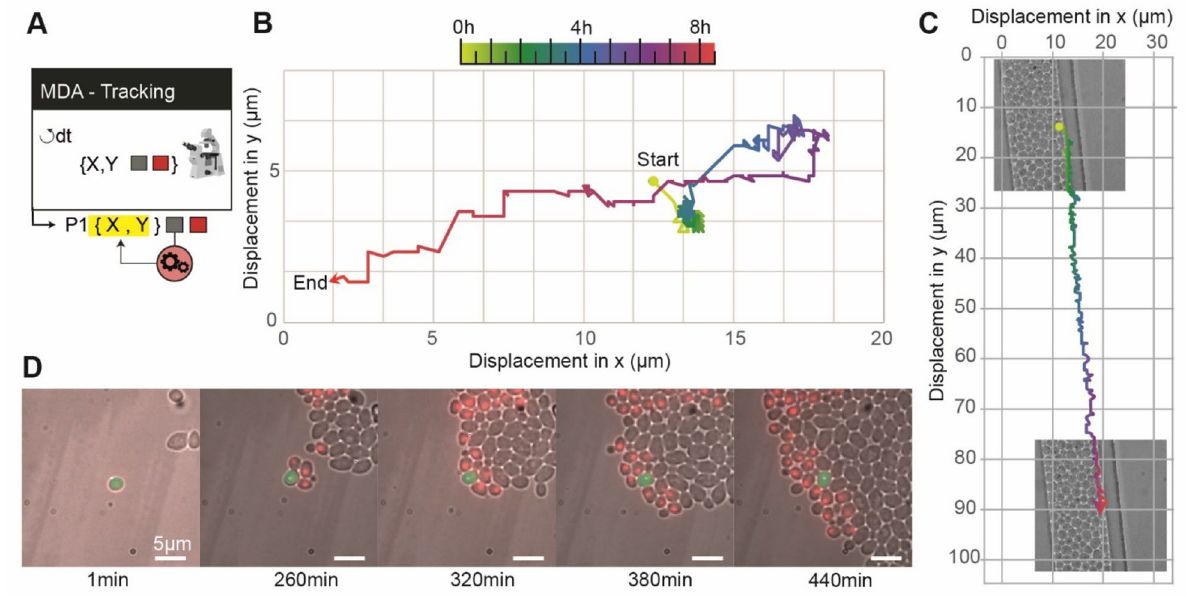
Figure 4. Detection and tracking of a cell of interest. ( A ) Sketch of the “detect and track scenario”. Once a cell of interest is found in the field of view, the field of view is centered on that cell and the stage is periodically moved to maintain this cell in the center of the field of view. ( B ) We mixed two populations of yeast cells in a microfluidic chamber, one of which express a HTB2-mCherry fluorescent reporter (1:10 cell ratio). The algorithm scans through several positions and when it detects cells with a signal in the RFP channel, picks one such cell randomly and centers it on the field of view. This cell is then tracked using brightfield segmentation, and the stage position is corrected through a feedback loop to compensate for cell displacement. ( C ) The cell of interest moves because it is pushed by the growth of neighboring cells, traveling approximately 20 µm during the course of the experiment. The real-time stage compensation keeps the cell in the center of the field of view. The duration of the experiment (around 9 h) is long enough to observe the appearance of the progeny of the cell of interest. ( D ) Tracking a non-fluorescent yeast cell growing in a dead-end narrow microfluidic chamber, leading to global directed motion of all cells. The tracked cell remains in the field of view, even though it travels approximately 80 µm; in contrast, the field of view is only ~ 25 × 25